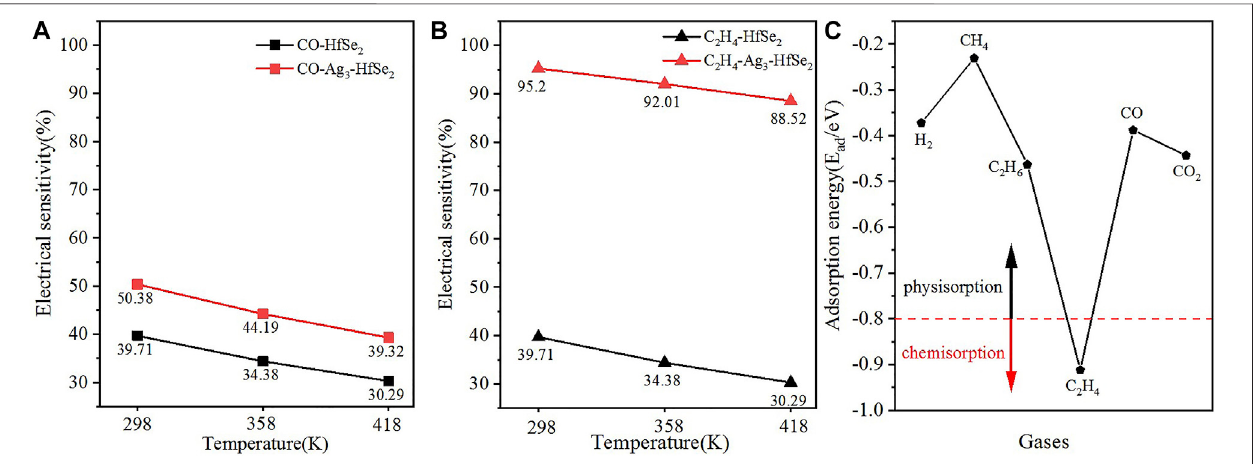
FIGURE 8 | Electrical sensitivity of (A) CO and (B) C 2 H 4 on pristine and doped adsorption systems. (C) Comparison of the adsorption energy of different gases.